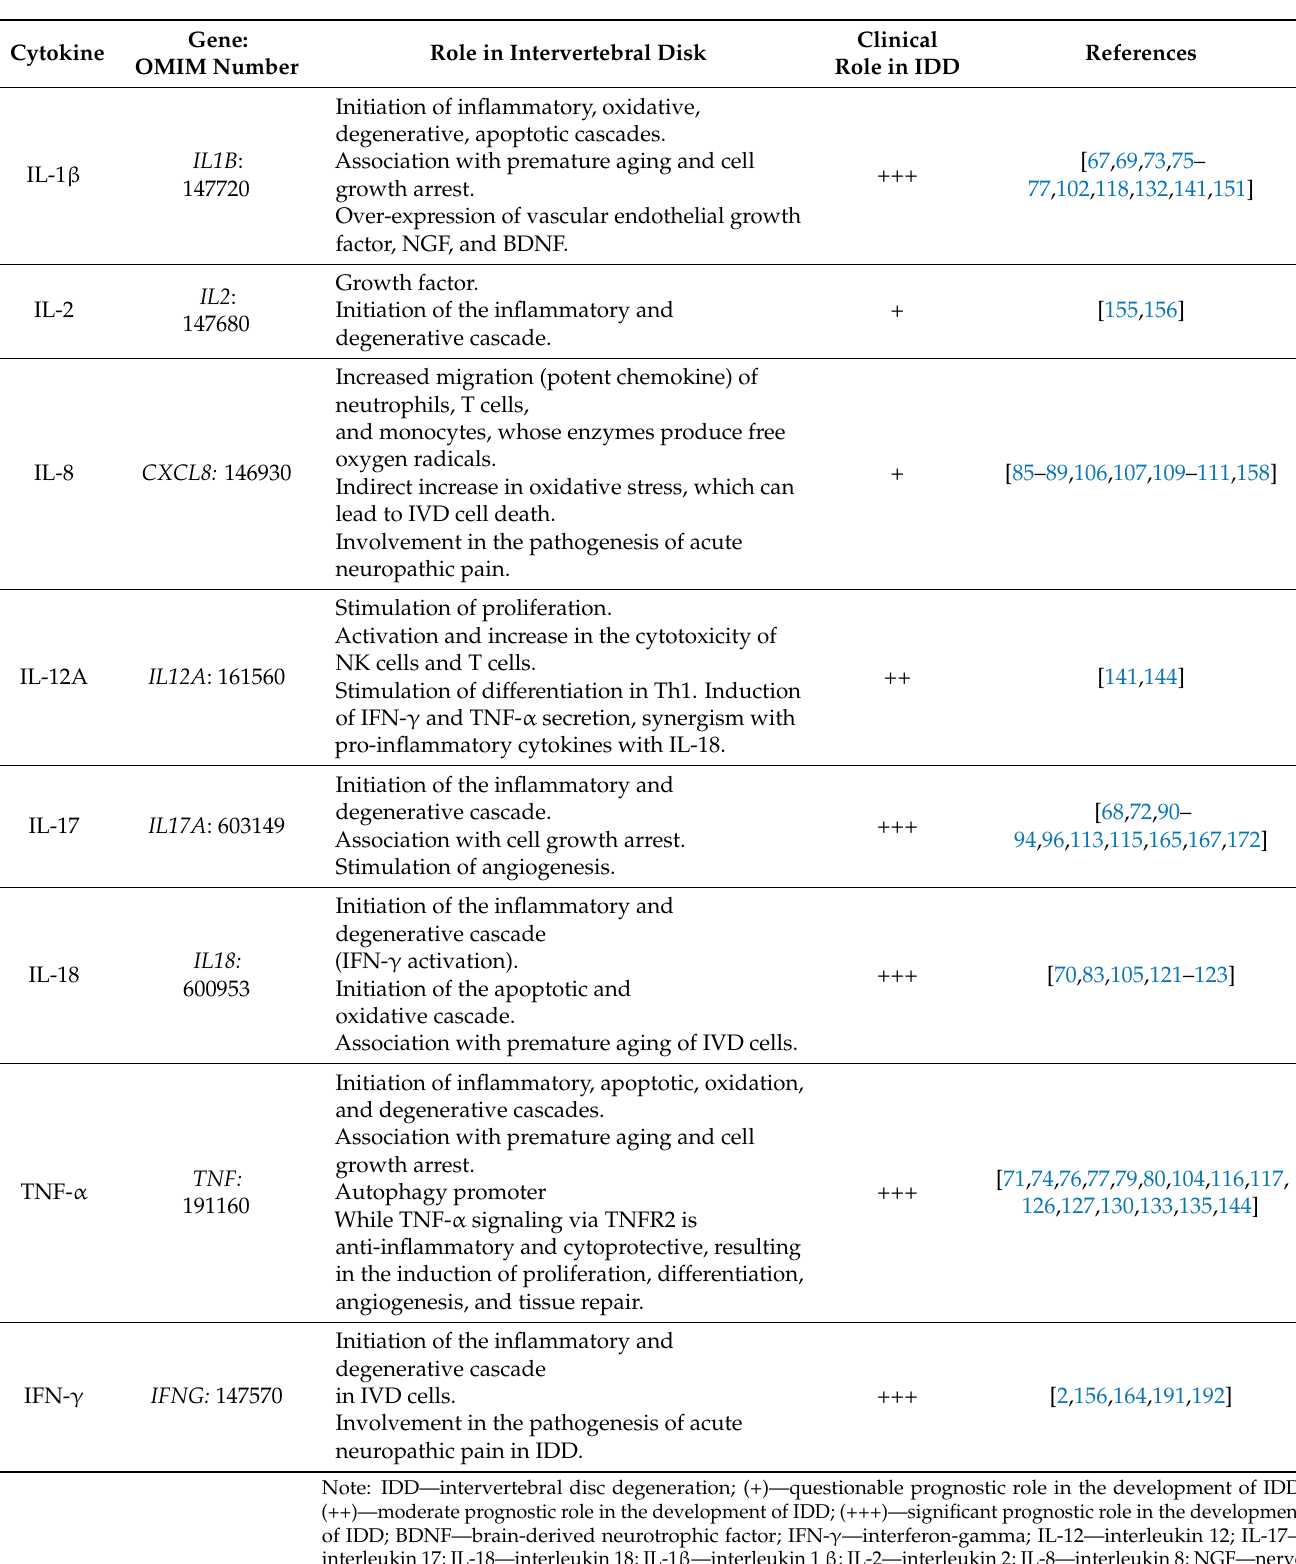
Table 4. Role of pro-inflammatory cytokines in intervertebral disk